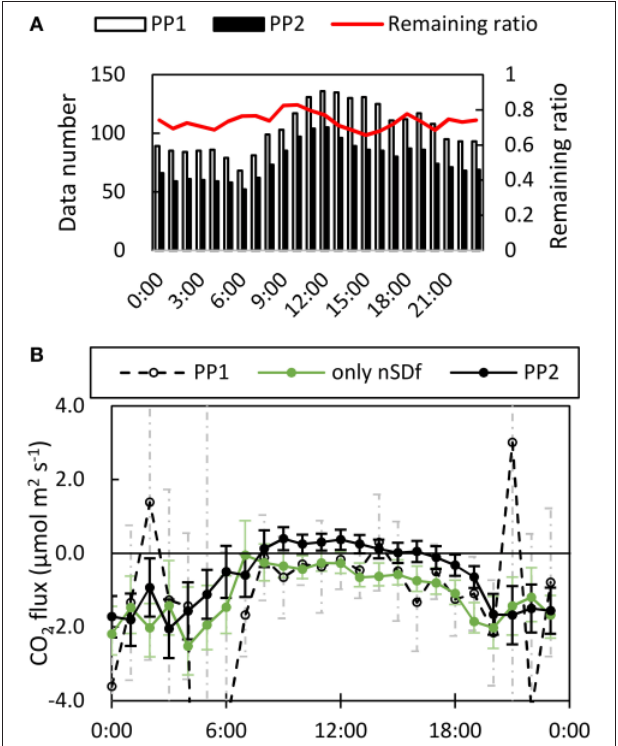
FIGURE 5 | Changes in (A) the number of data points and (B) average value of diurnal flux by filtering. Some plots of data after PP1 were omitted for clarity. The remaining ratio of the flux data after PP2 (red line) was almost the same between daytime and nighttime. In contrast, the average value in the daytime shifted to positive (efflux). The shift was caused by high-pass filtering (black solid line and closed circles), not the filtering using nSD (dashed line and open circles to green data). The error bars mean the 95% confidential limit.